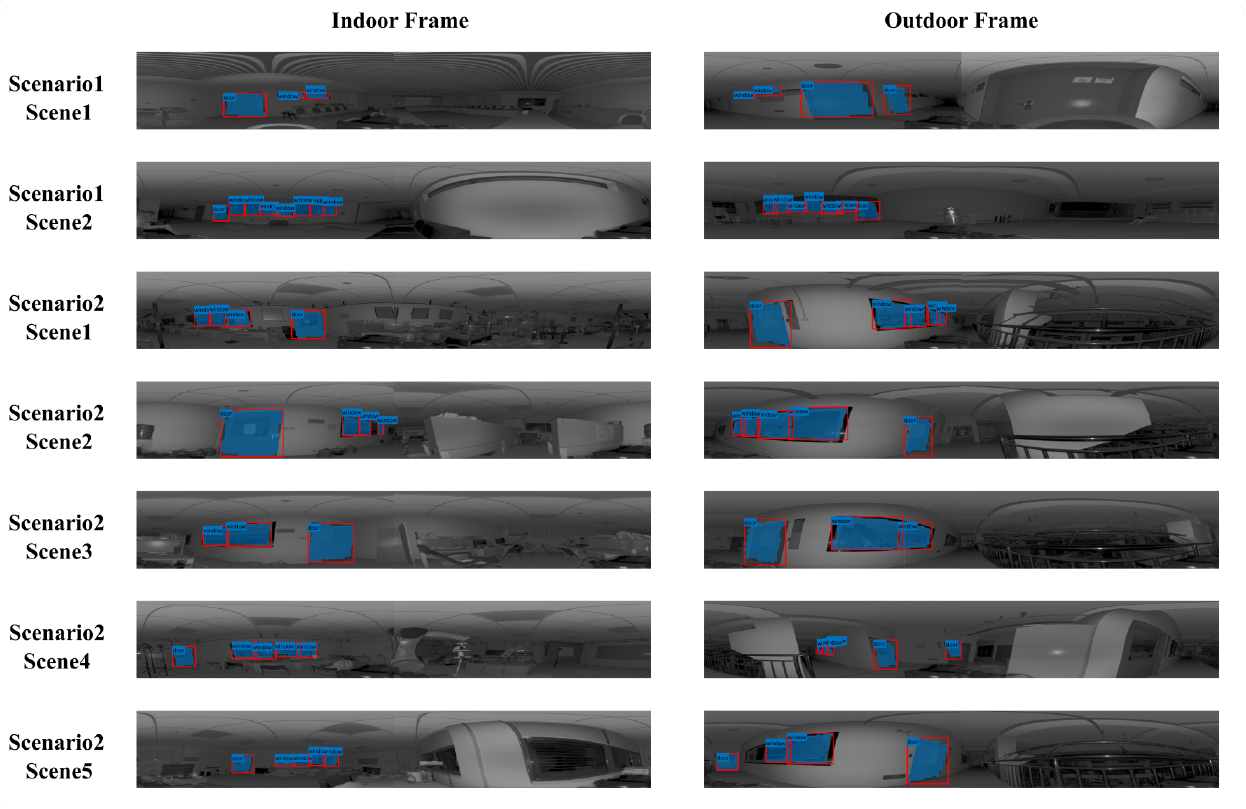
Figure 9. The projected LiDAR images for two scenarios and the windows and doors in the image are recognized using the 2D segmentation method.